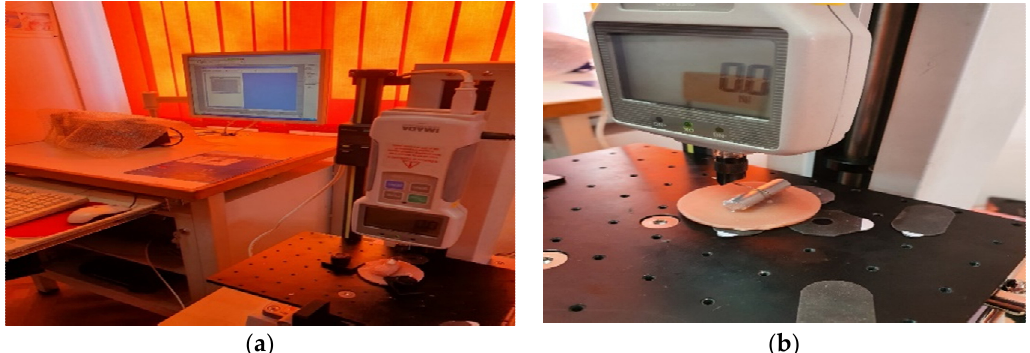
Figure 4. ( a ) HV 500N stand used for spring testing; ( b ) force transducer.